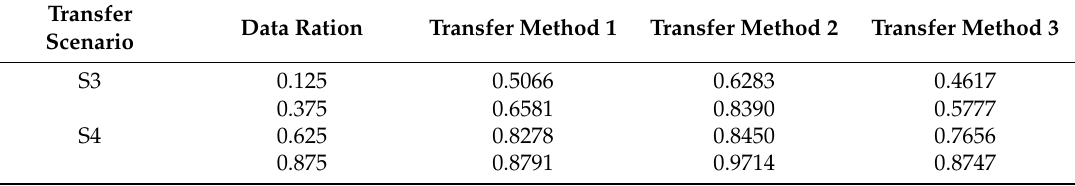
Table 6. Summary of Correctness Rate of Transfer Test between Di ff erent